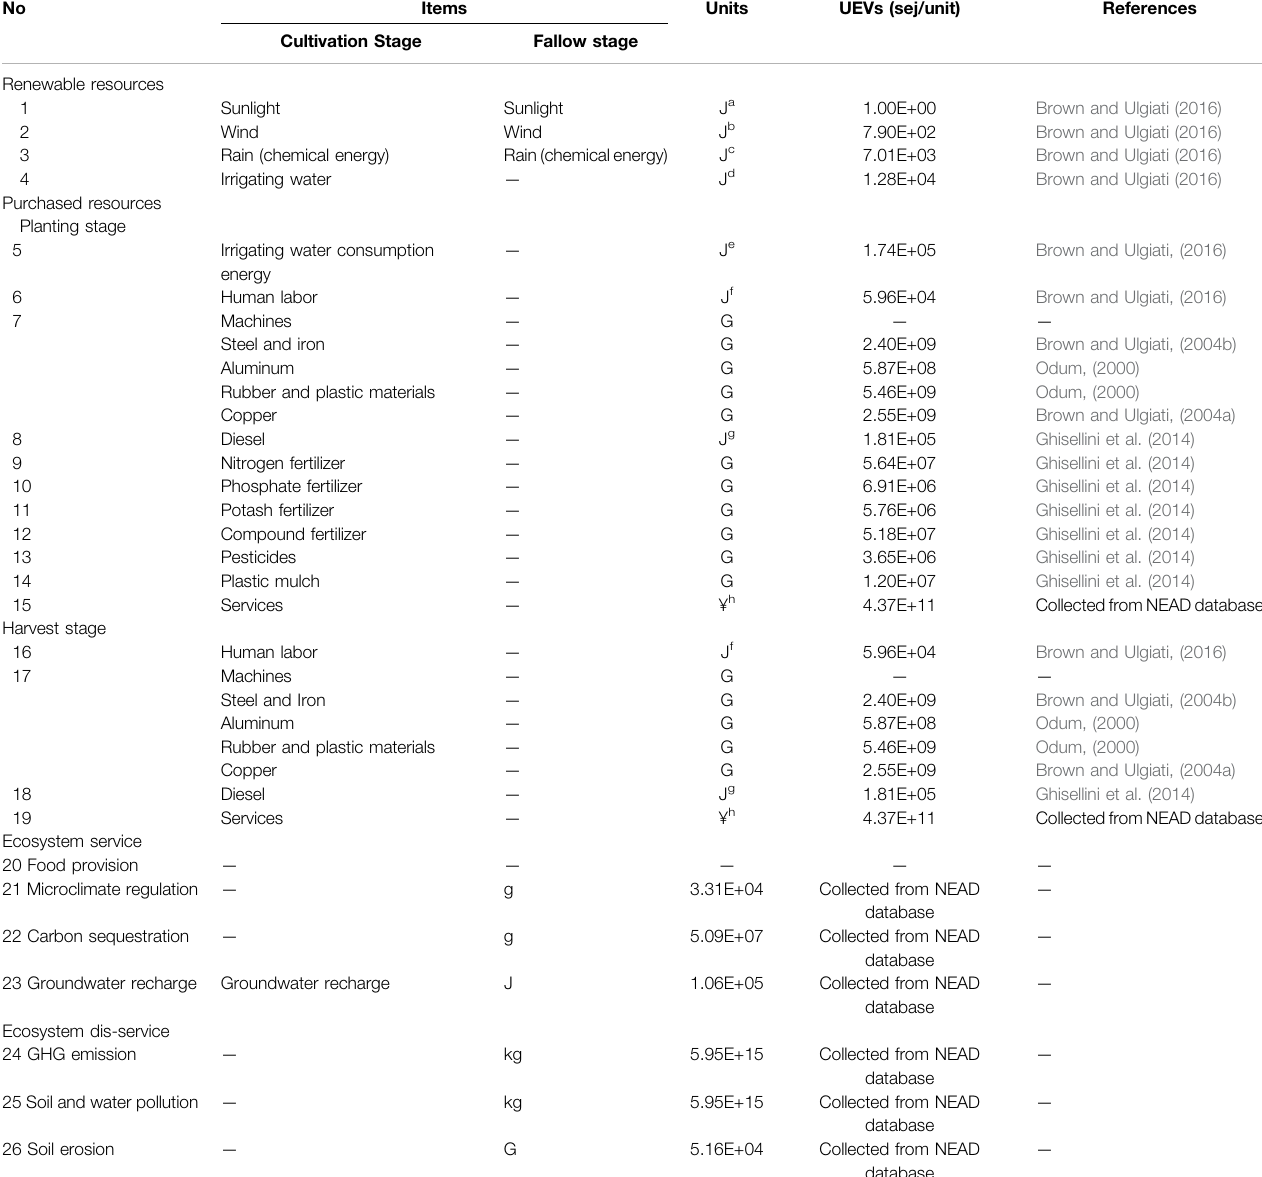
TABLE 2 | Emergy fl ows and corresponding unit emergy values